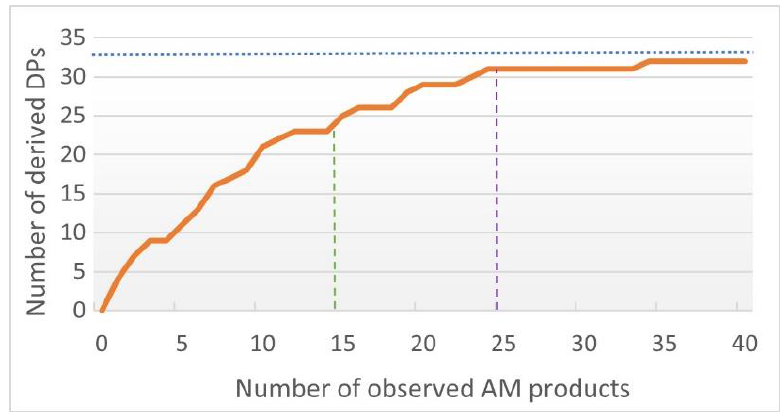
Figure 3. Example: Analysis of AM milireactor.